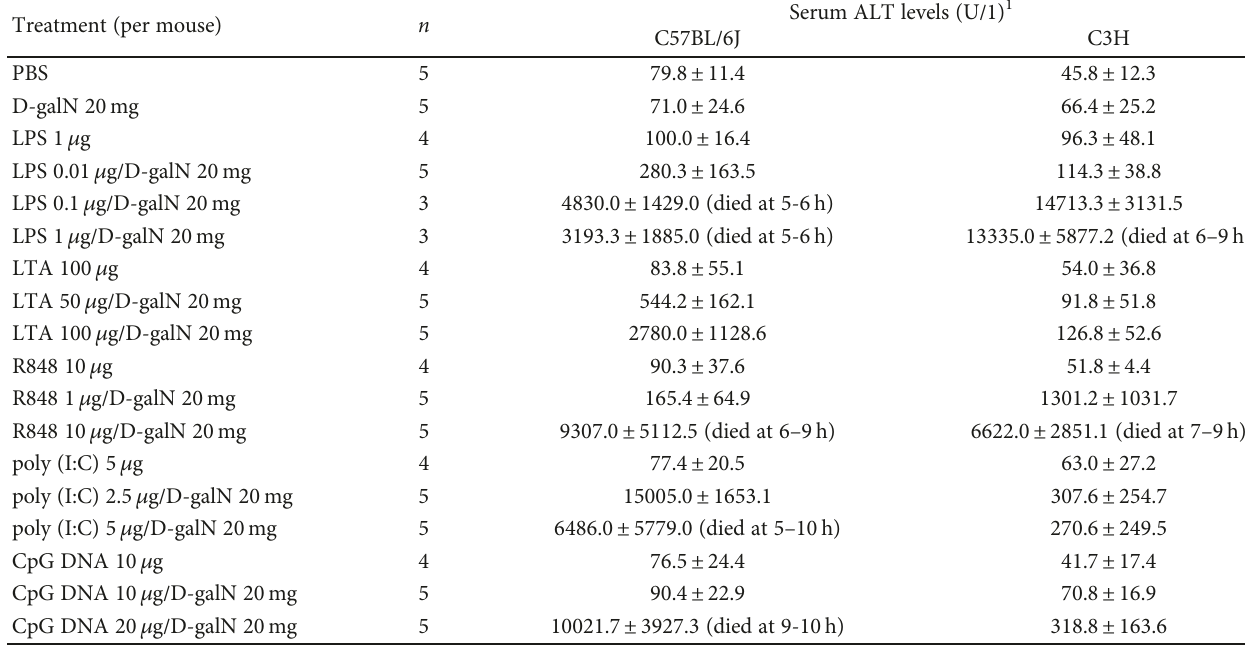
Table 1: Serum ALT levels in each TLRL/D-galN-treated mouse. Mean ± SD is shown. Treatment (per